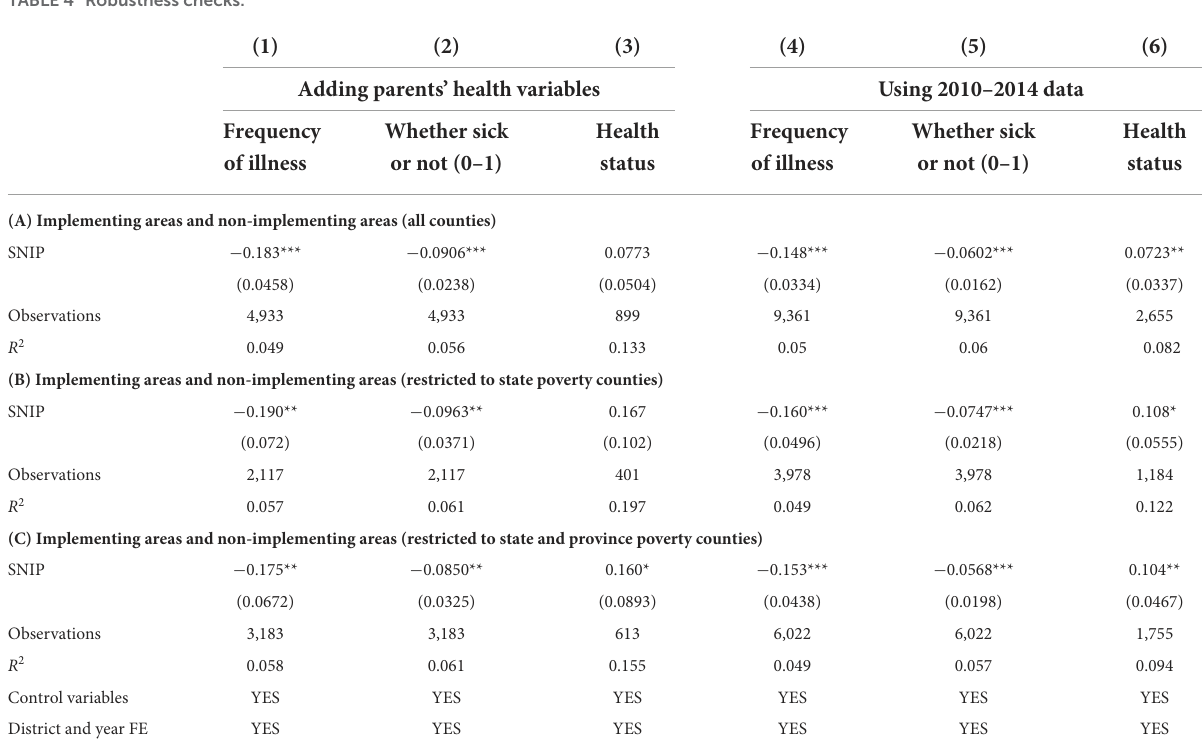
TABLE 4 Robustness